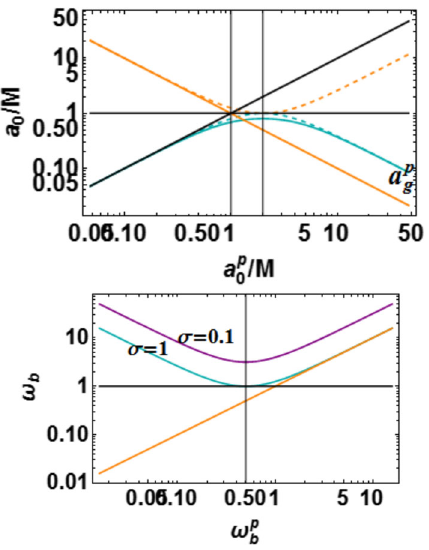
Fig. 11 Analysis of Eq. (40). Upper panel: for σ = 1, a p g of the corresponding bundle (cyan), origin of the corresponding MBs (cyan, ) (orange), frequency of the corresponding dashed), frequency ( 1 / a p 0 MBs (orange dashed), origin a p (black) as function of a p . The below 0 0 panel illustrates the frequencies relations ω p as functions of the bundle b frequencies of Eq. (40) for different planes σ . The orange line is the ω = ω p b